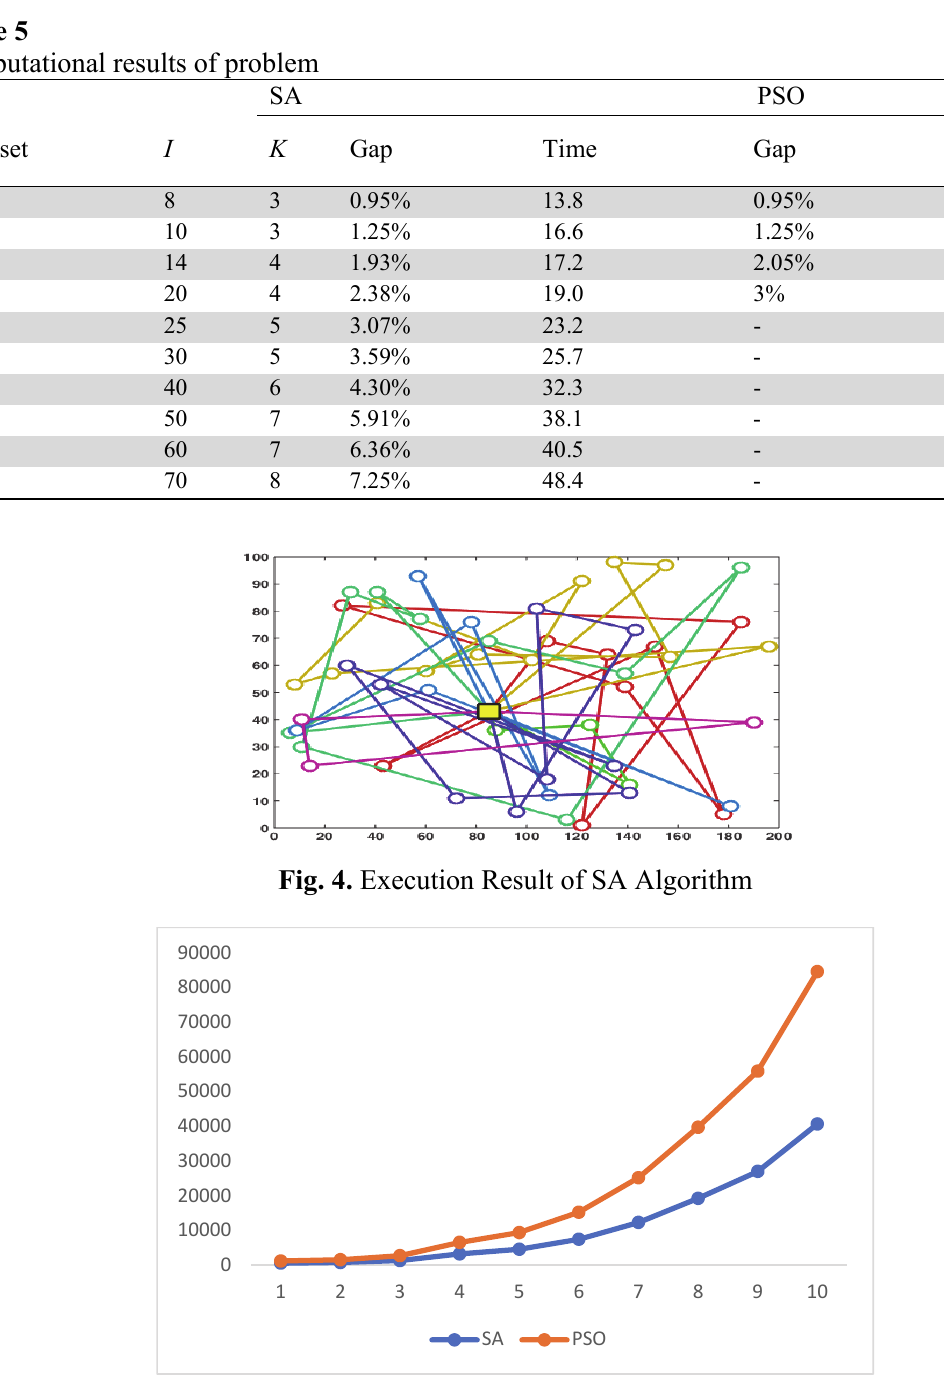
Fig. 5. Runtime Comparison of test